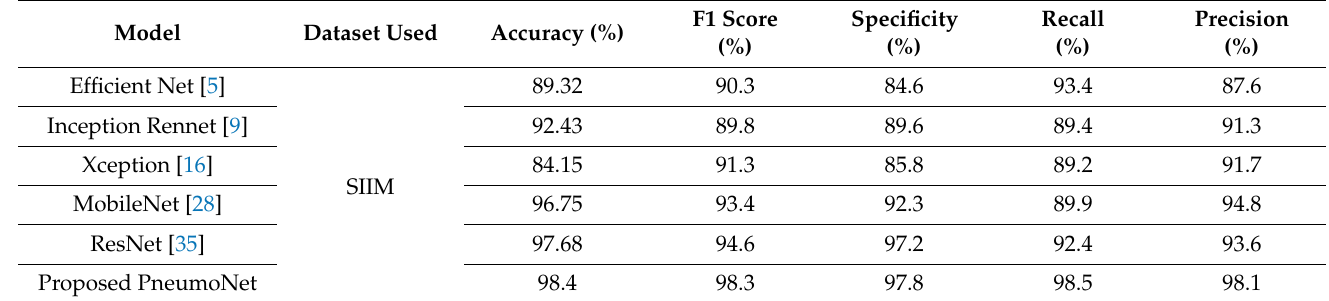
Table 14. Performance comparison of existing and proposed